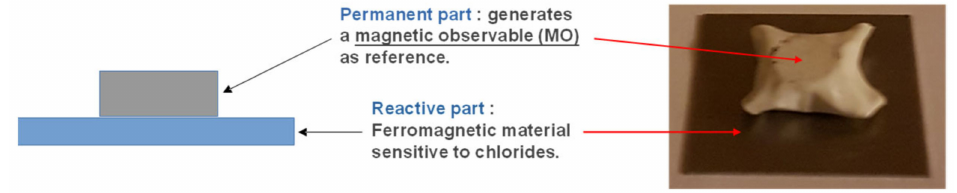
Figure 1. Schematic representation of a single Functional Magnetic Material